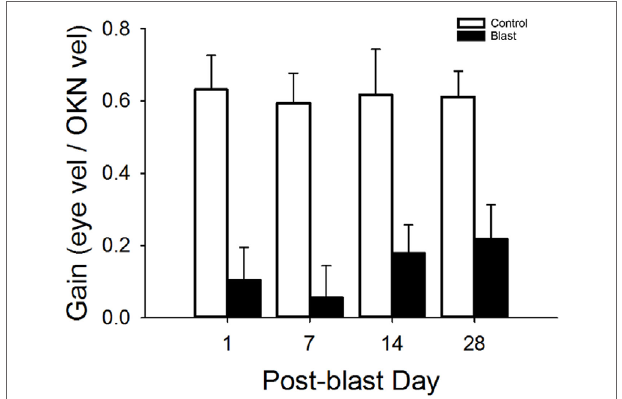
FigUre 5 | Mean OKN responses. Mean OKN responses for control and blast animals as a function of post-condition day exposure (control = white, black = blast). Error bars = SE.